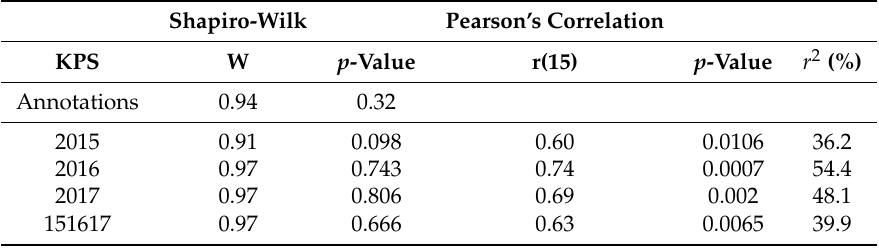
Table 6. Correlation analysis via Pearson’s correlation coefficient for KPS of the four MNC models against the annotation KPS. Pearson’s assumes a normal distribution in the data which is evaluated through a Shapiro-Wilk normality